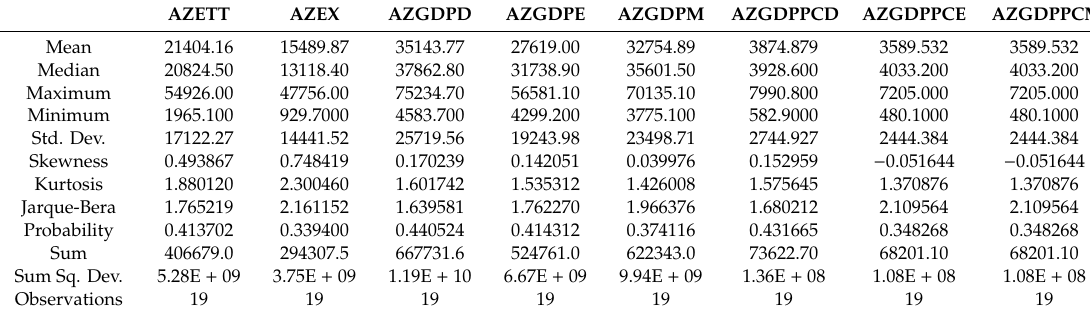
Table A4. AZ. Descriptive statistics.